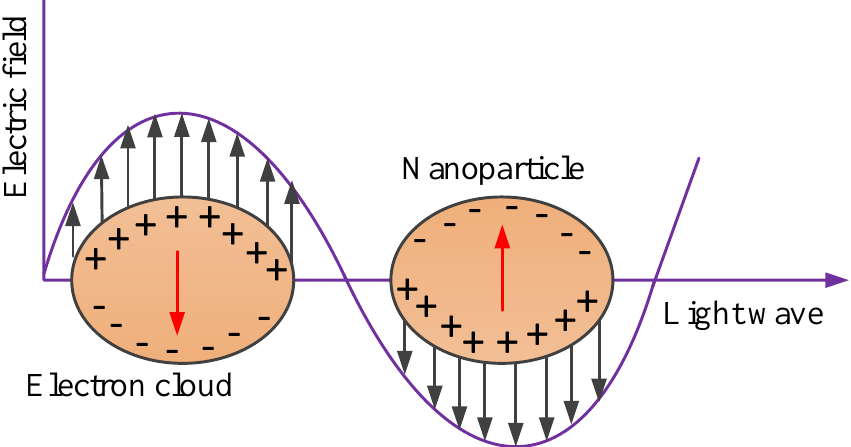
Figure 5. Localised surface plasmon resonance (LSPR) due to collective oscillations of delocalised electrons in response to external electric field [40].